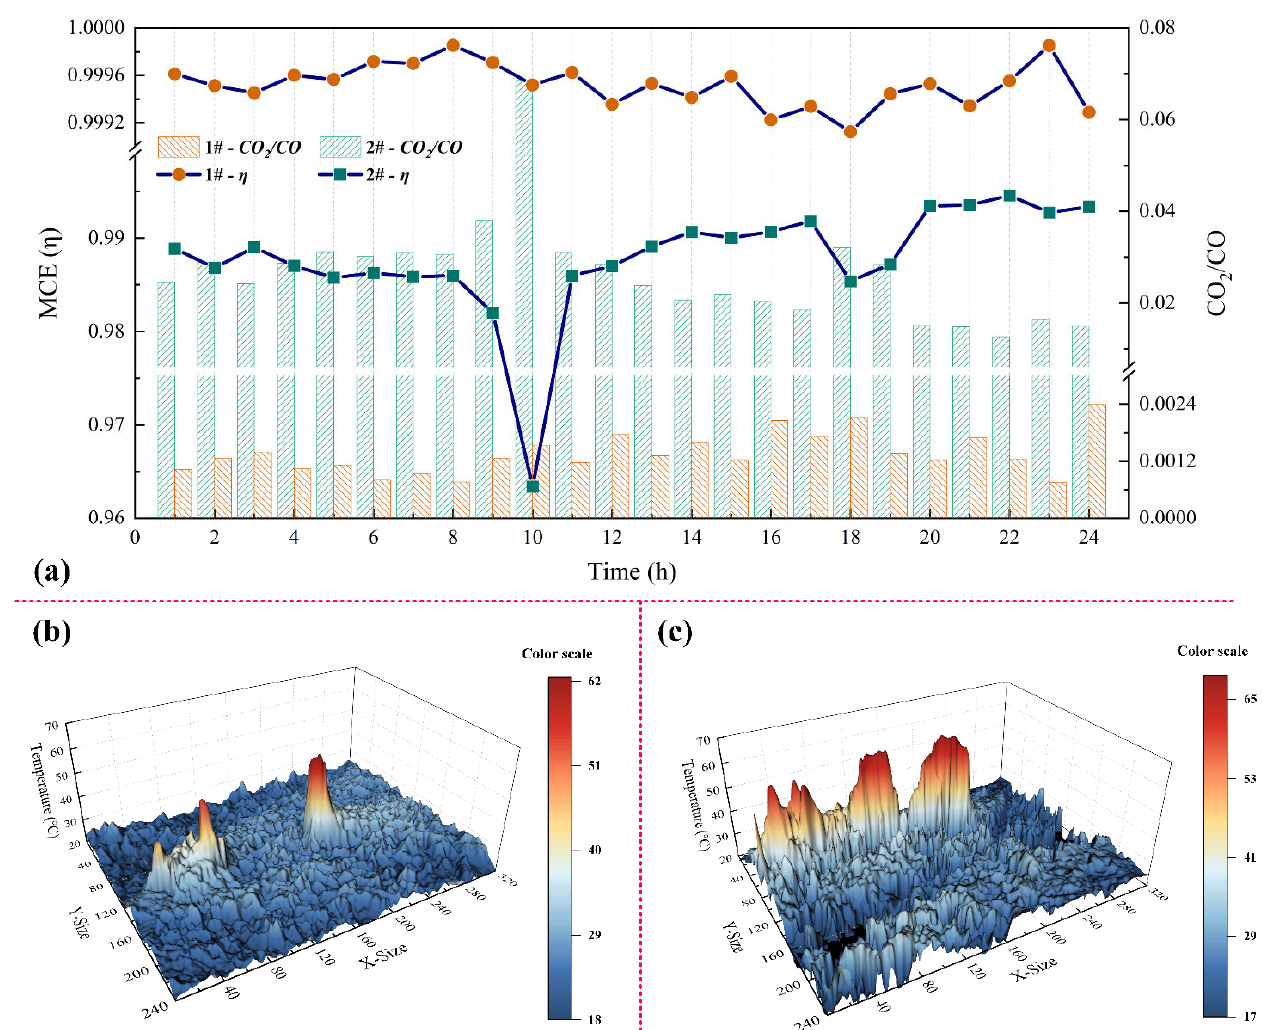
Figure 8. Analysis of coal seam re-burning degree. ( a ) Time variation law of MCE and CO 2 /CO ratio; ( b ) temperature characteristic diagram of fissure 1# in research point; ( c ) temperature characteristic diagram of fissure 2# in research point.